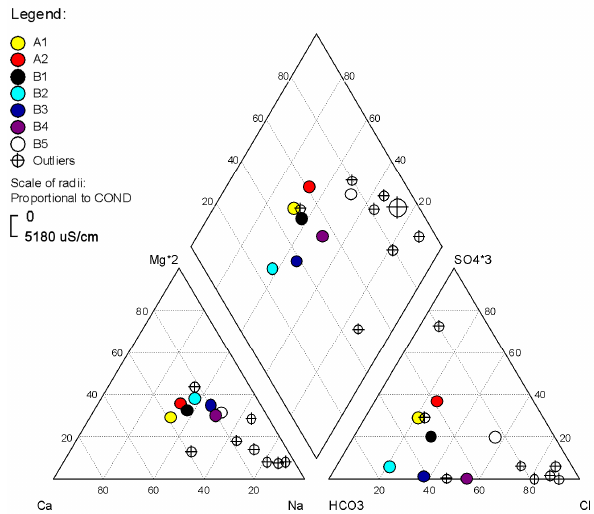
Fig. 6. Piper diagram showing the variation of mean values for major ions (see Table 2) amongst the seven defined clusters and eight outlier sites. Mg and SO 4 scales are exaggerated to increase separation of points on the diagram; circles in center diamond are proportional to conductivity.